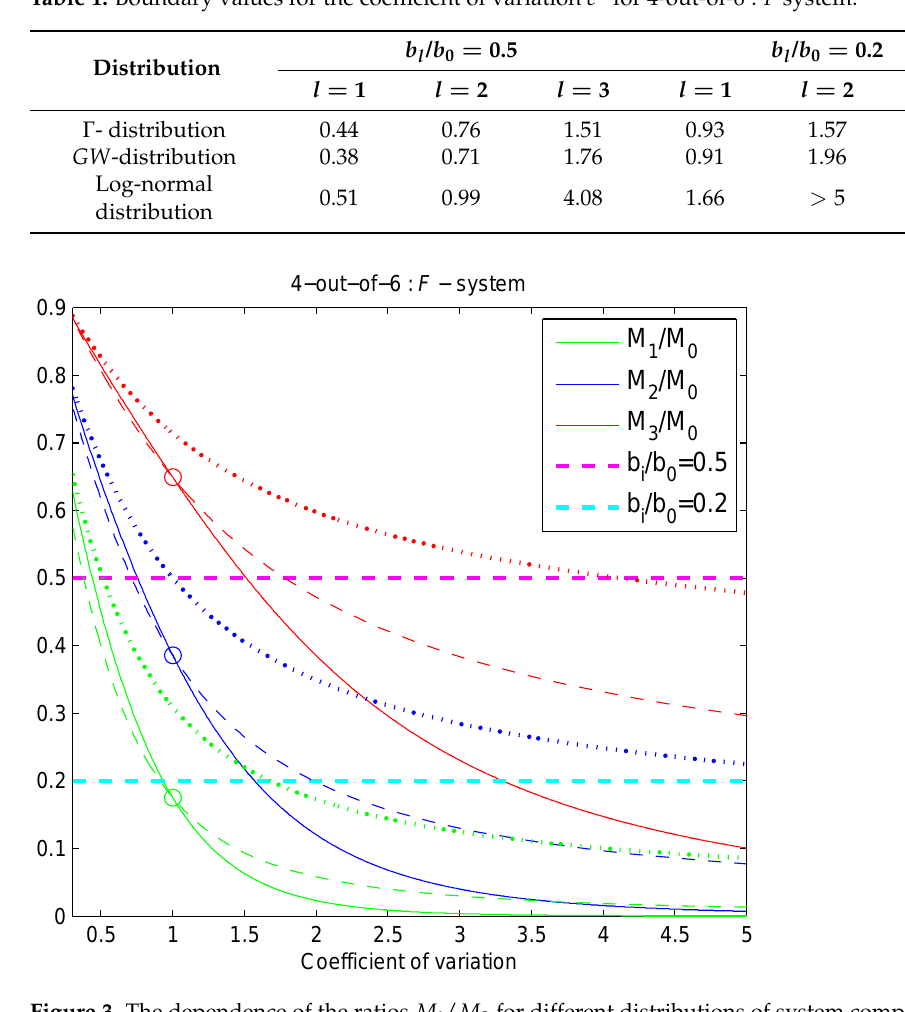
Figure 3. The dependence of the ratios M l / M 0 for different distributions of system components life- time versus their coefficient of variation for 4-out-of-6 : F system. Solid lines— Γ -distribution, dashed lines— GW -distribution, dotted lines—log-normal distribution, circles—exponential